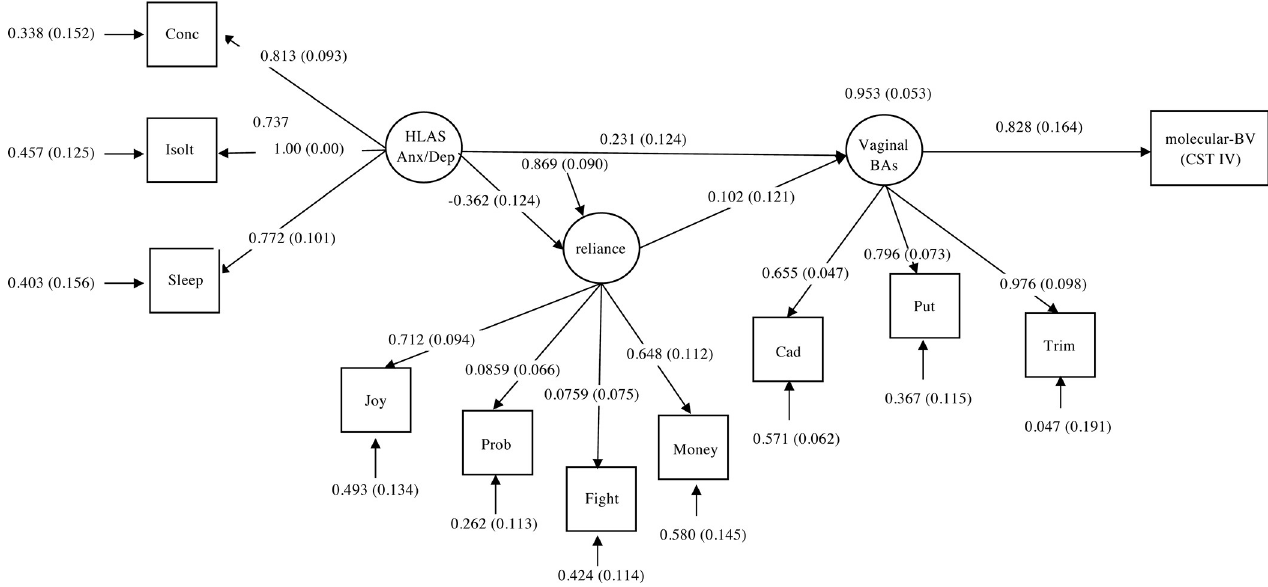
Fig 5. Structural equation model (SEM) with standardized results. Pathway to molecular-BV (CST IV) through interpersonal reliance and vaginal biogenic amines.